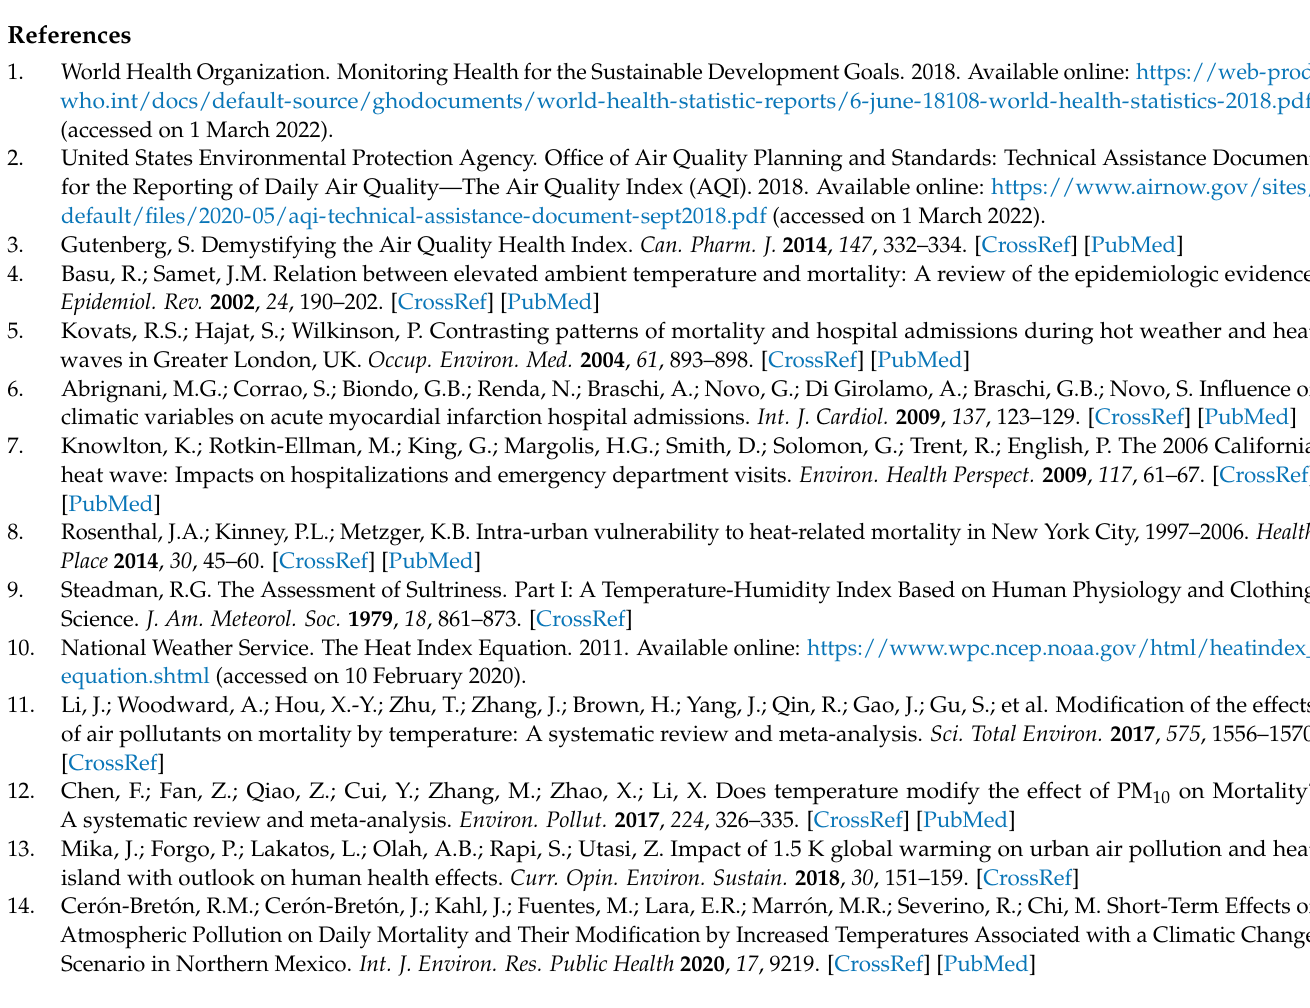
Figure S3: Daily nitrogen dioxide (NO 2 ) concentrations by muncipality, Figure S4: Daily carbon monox- ide (CO) concentrations by muncipality, Figure S5: Daily ozone (O 3 ) concentrations by muncipality, Figure S6: Daily particulate matter (PM 2.5 ) concentrations by muncipality, Figure S7: Daily particulate matter (PM 10 ) concentrations by muncipality, Figure S8: Daily Heat Index (HI) by